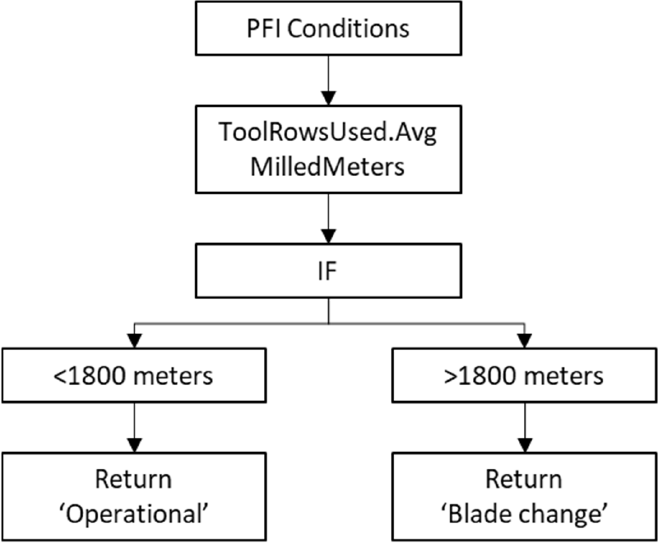
Figure 4. Given conditions to the PFI algorithm.